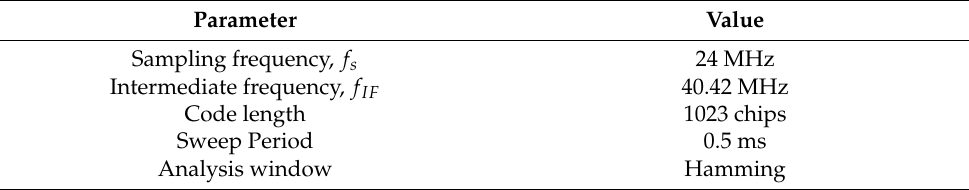
Figure 8. The experimental platform of the GNSS interference detection test. Table 1. Setup parameters in the GNSS interference detection